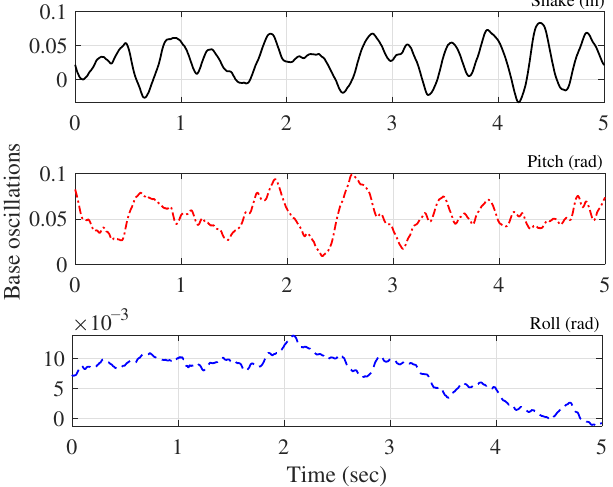
Figure 7. Three base